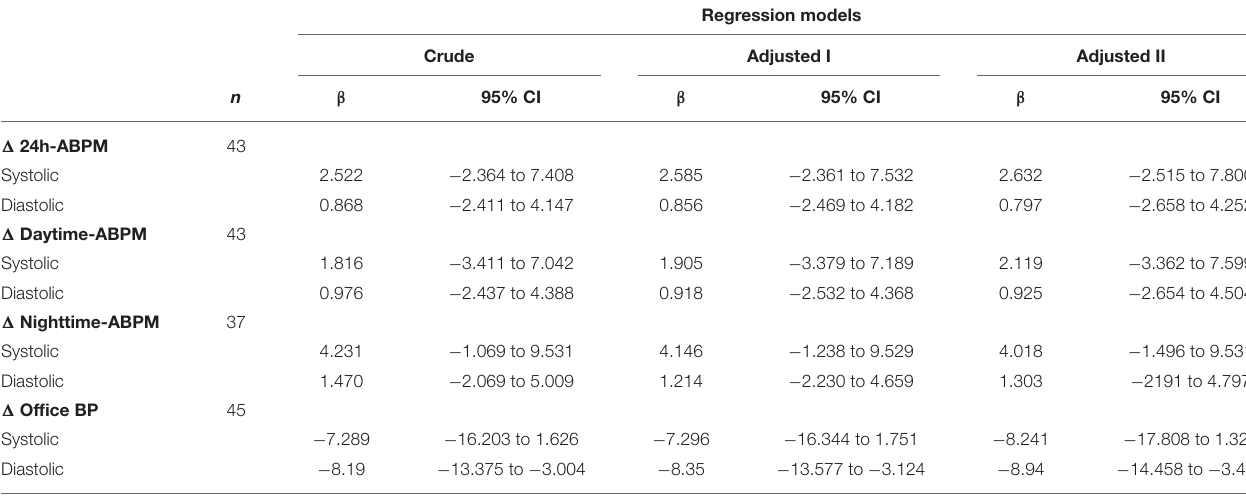
TABLE 3A | Association of systolic and diastolic blood pressure change (mmHg) with respect to study group.